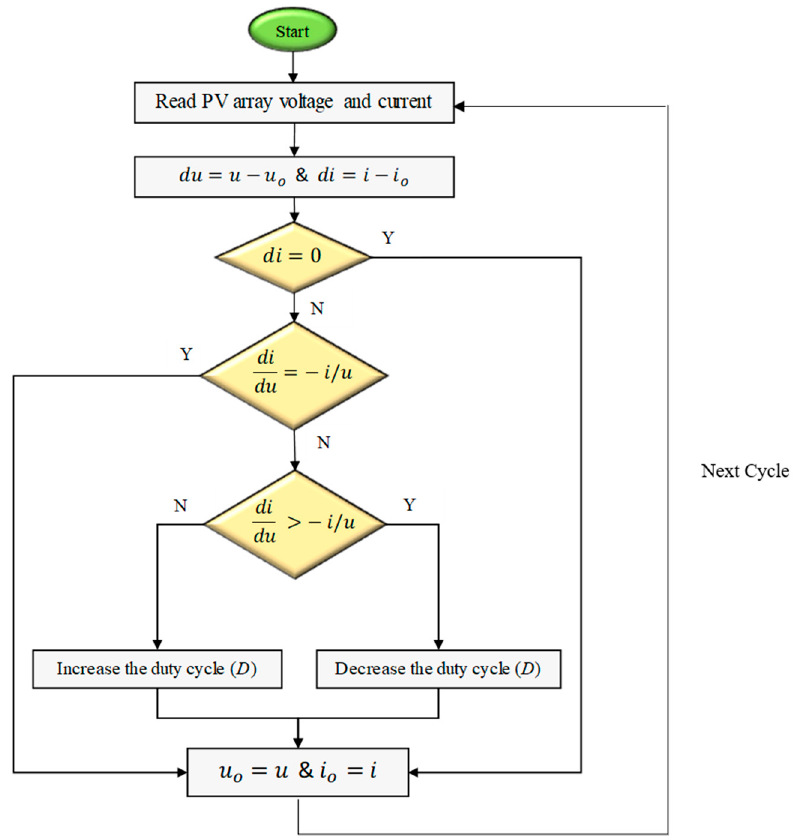
Figure 4. Flow chart of incremental conductance MPPT.